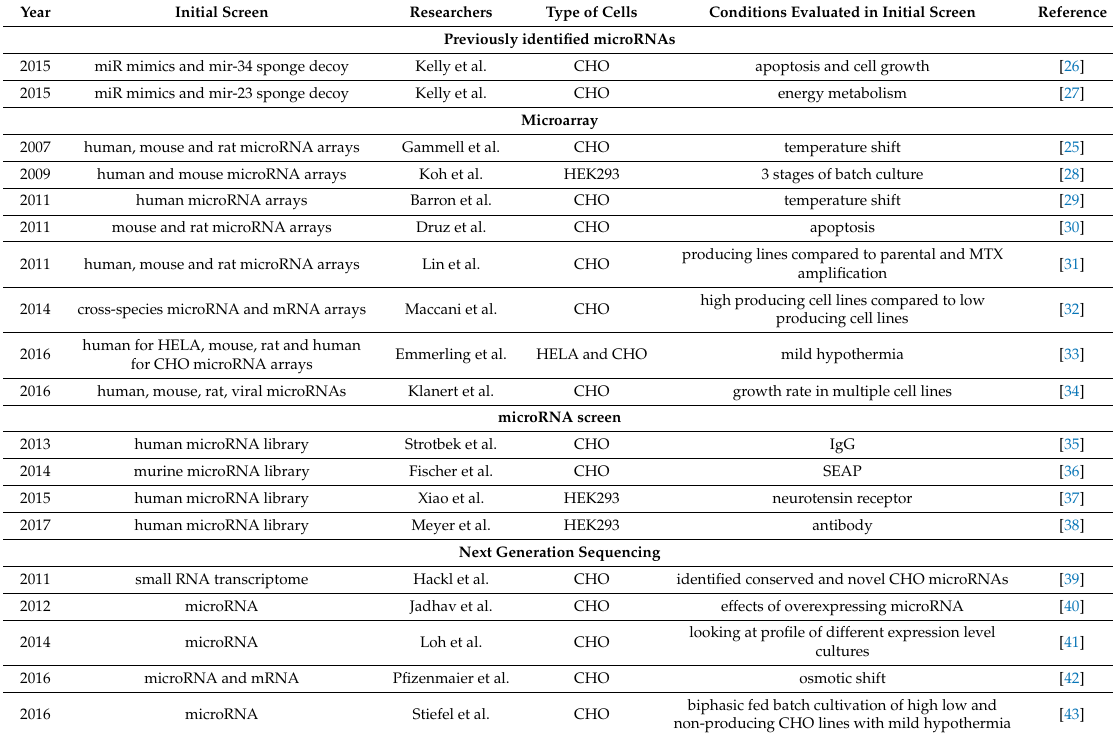
Table 1. Summary of microRNA screening